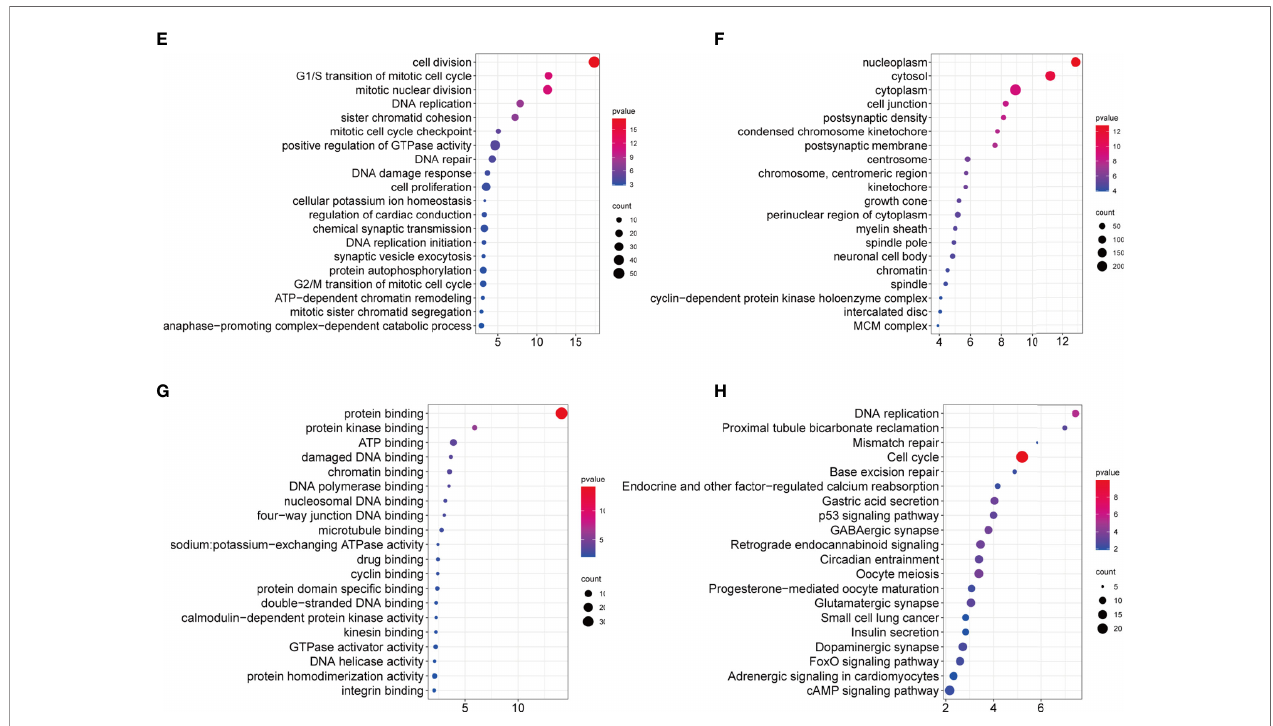
FIGURE 2 | GO analysis and KEGG pathway analysis of DEGs. (A – D) GO analysis and KEGG pathway analysis. Bubble diagram of BP (E) , CC (F) , MF (G) and KEGG (H) analysis for